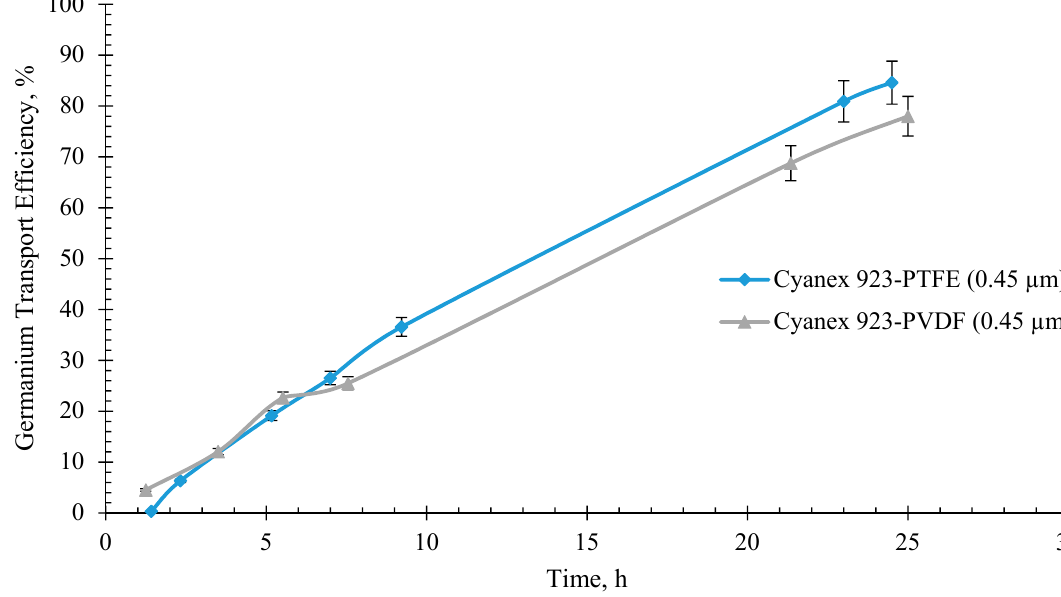
Figure 6. Transport efficiency of germanium through polytetrafluoroethylene (PTFE) and polyvinylidene difluoride (PVDF) membranes versus time ([Oxalic acid] = 0.075 mol / L, temperature of 22 °C, [Cyanex 923] = 20% v/v, and [NaOH] = 0.1 mol/L).